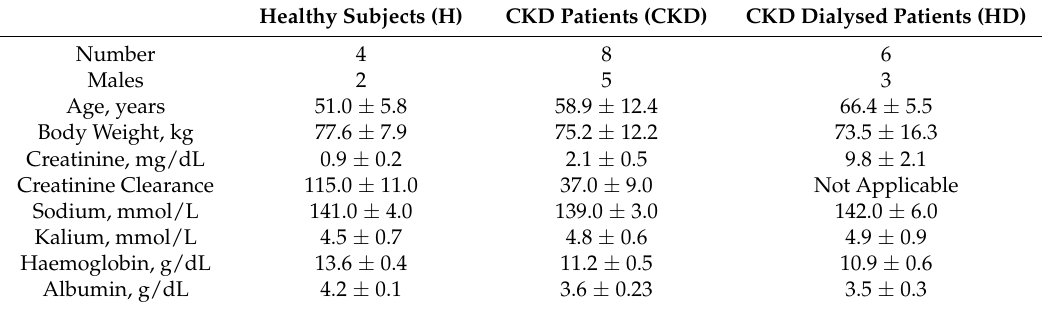
Table 1. Anthropometric data and ematochemical values of the subjects participating in the